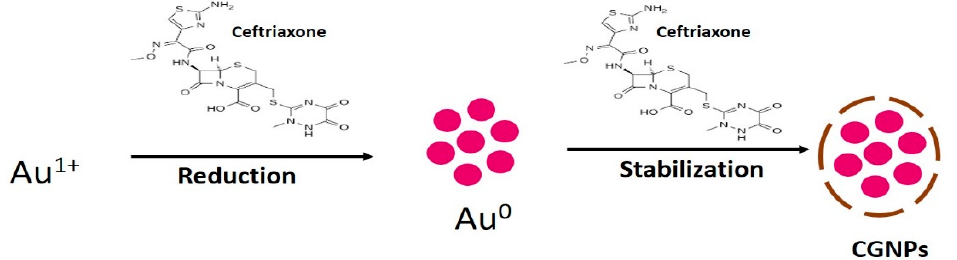
Figure 1. Scheme of ceftriaxone-mediated synthesis of gold nanoparticles. Here, CGNPs are the ceftriaxone-stabilized gold nanoparticles.